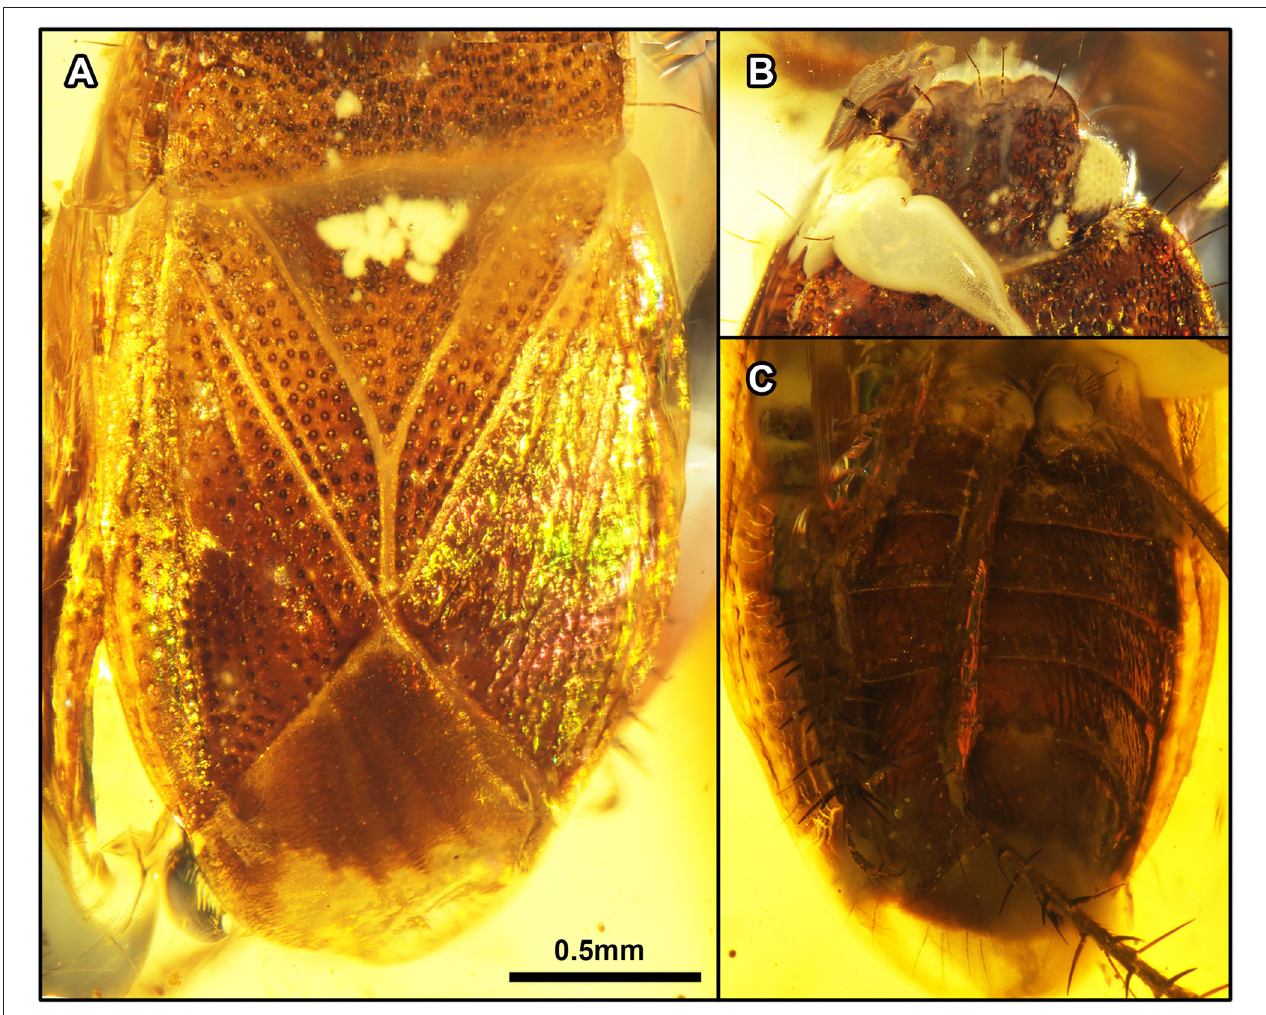
FIGURE 8 | Quinalveus hui gen. et sp. nov., in Burmese amber. Holotype, CNU-HET-MA2019005 (male). (A) Scutellum and forewings in dorsal view. (B) Head in dorsal view. (C) Abdomen in ventral view. Scale bars: A = B = C = 0.5mm.